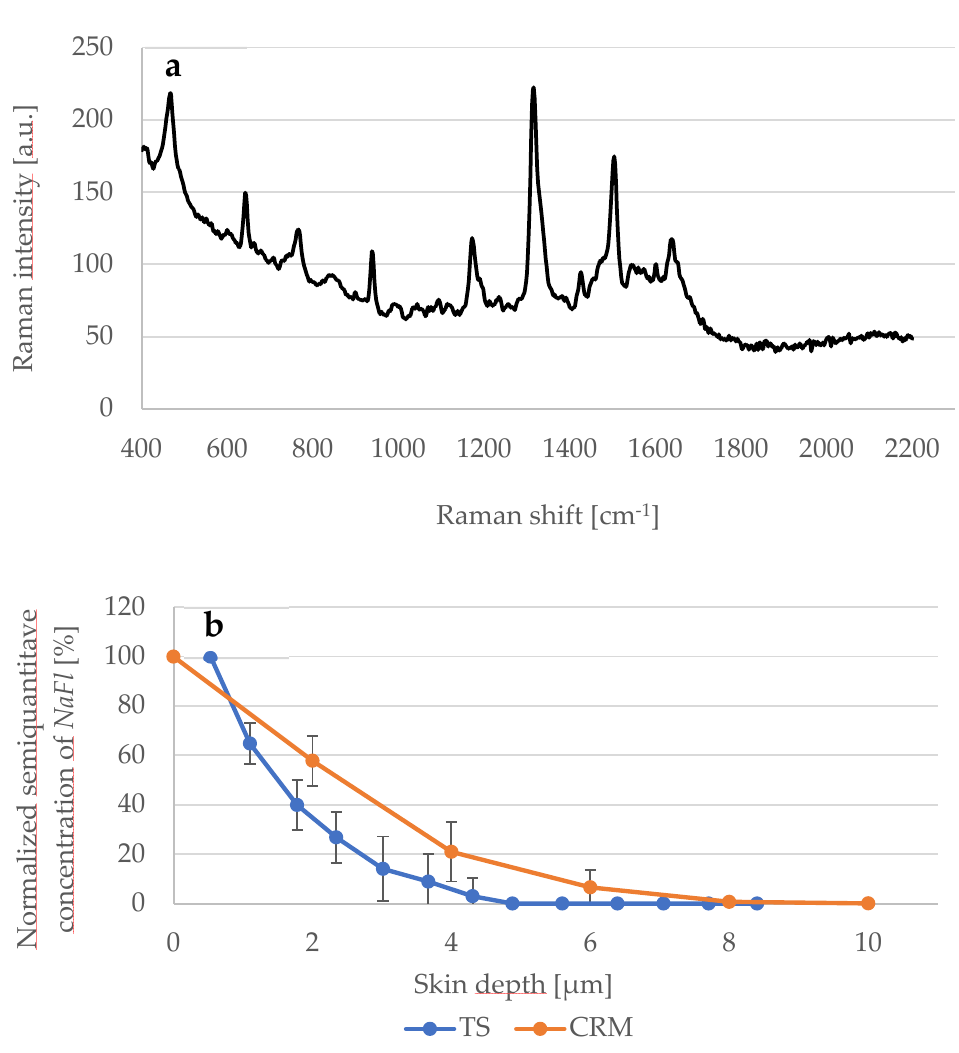
Figure 6. ( a ) Raman spectrum of NaFl excited at 785 nm; ( b ) Comparison between the detected NaFl concentration depending of the skin depth determined using CRM (orange line) and TS (blue line) methods. N = 6.